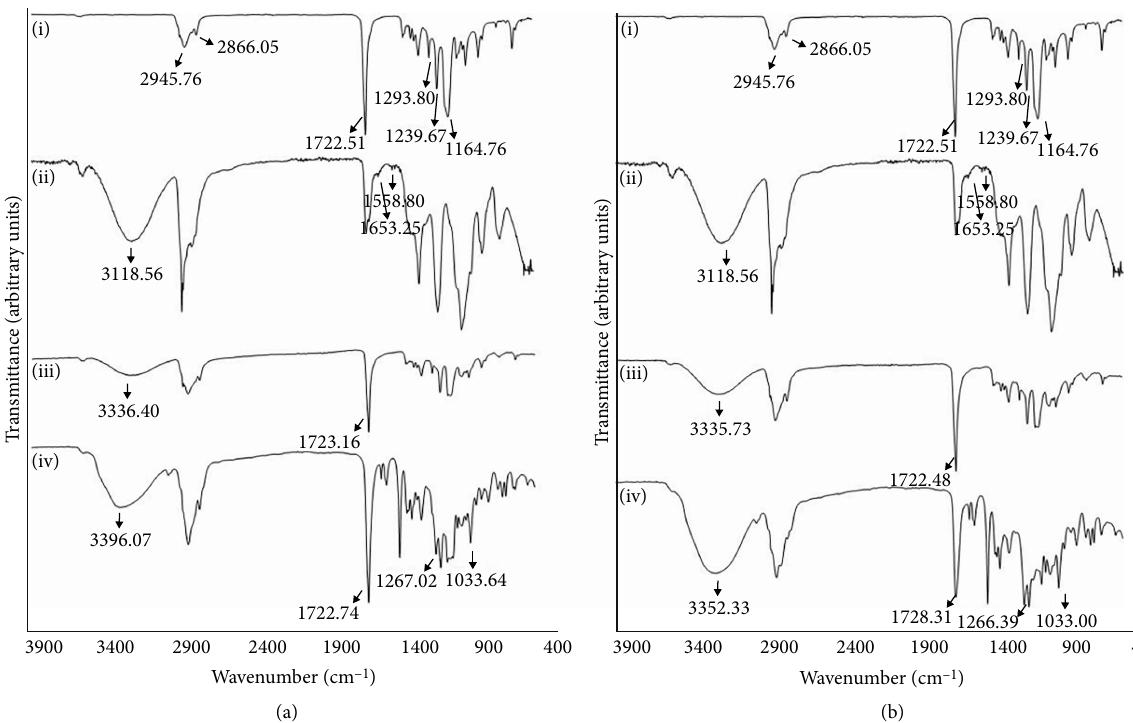
Figure 1: FT-IR spectrums of pure PCL (i), PVA/CS (ii) and electrospun PCL/PVA/CS fiber mats from W/O emulsion (a) and from O/W emulsion (b). Electrospun PCL/PVA/CS fiber mats without loaded EUG (iii) and with 5% owf EUG